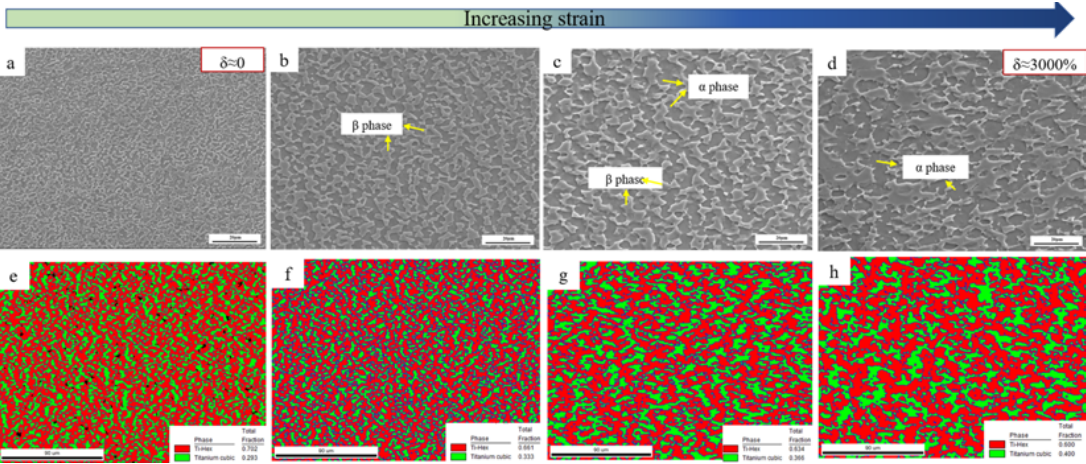
Figure 5. SEM images and phase fraction maps of SP700 alloy at different positions at 760 °C: ( a , e ) the grip position, ( b , f ) the gauge section near the grip, ( c , g ) the middle of the gauge section, and ( d , h ) section near the tip of the fracture.